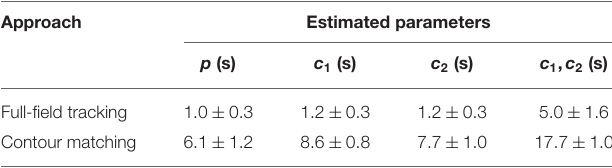
TABLE 1 | Wall-clock times for parameter estimation using the proposed strategies.